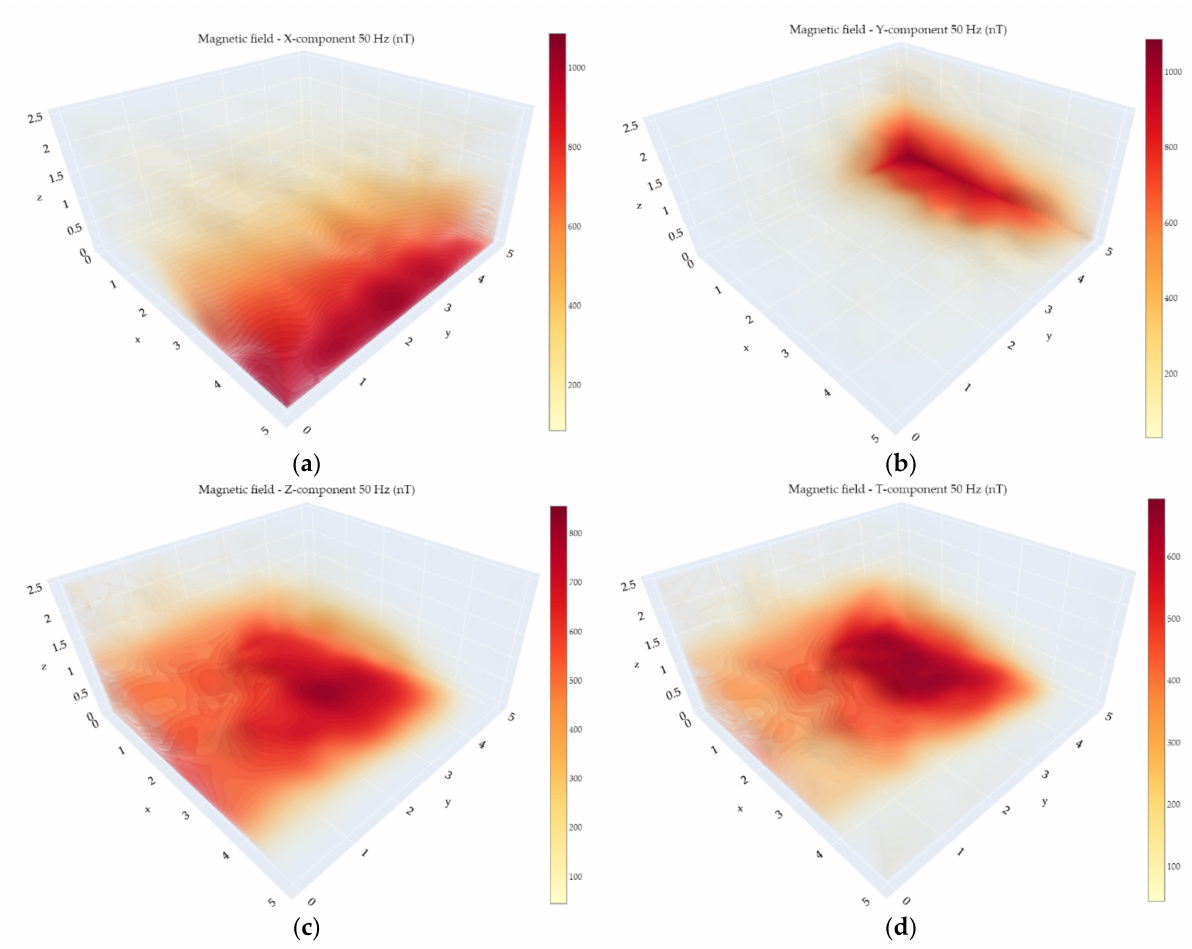
Figure 14. 50 Hz amplitudes of the magnetic field measured with the VEMA magnetometer: ( a ) X-component; ( b ) Y-component; ( c ) Z-component; ( d )